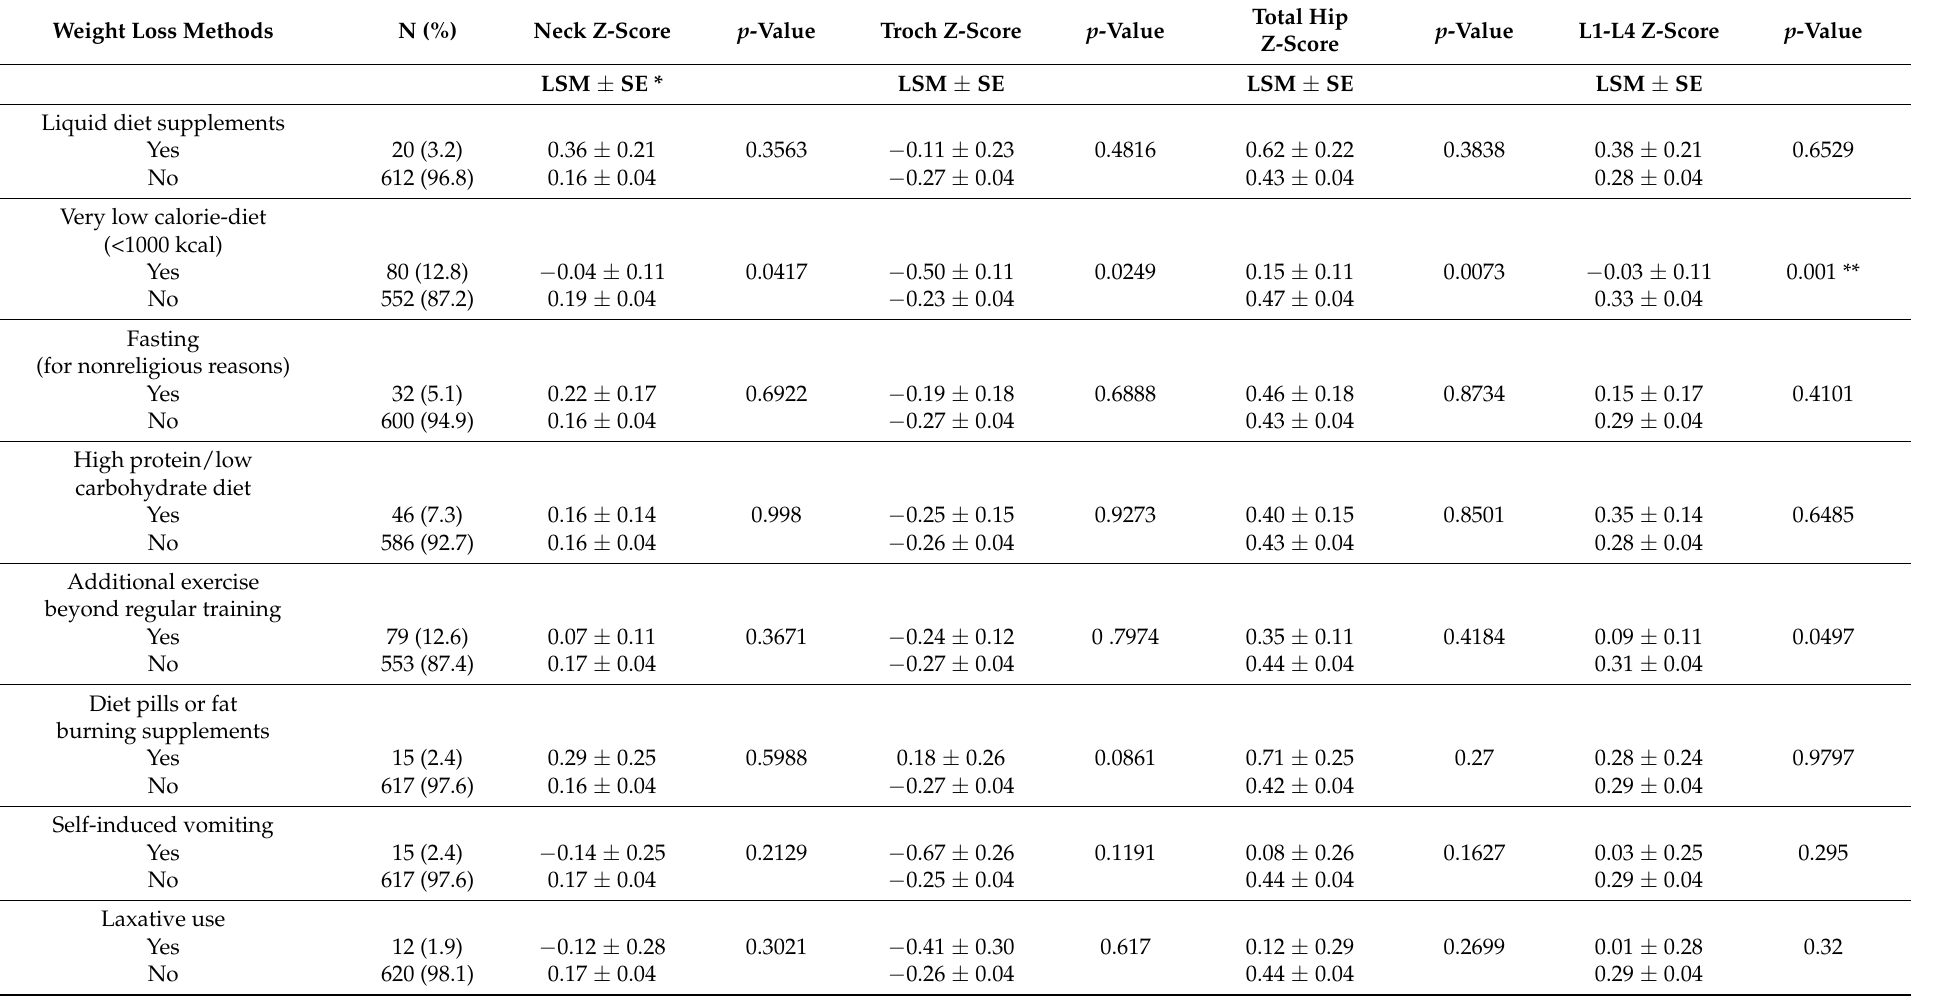
Table 2. Difference of BMD Z-score at each measurement site between weight change patterns and weight loss methods (Mixed Model ANOVA) (N =